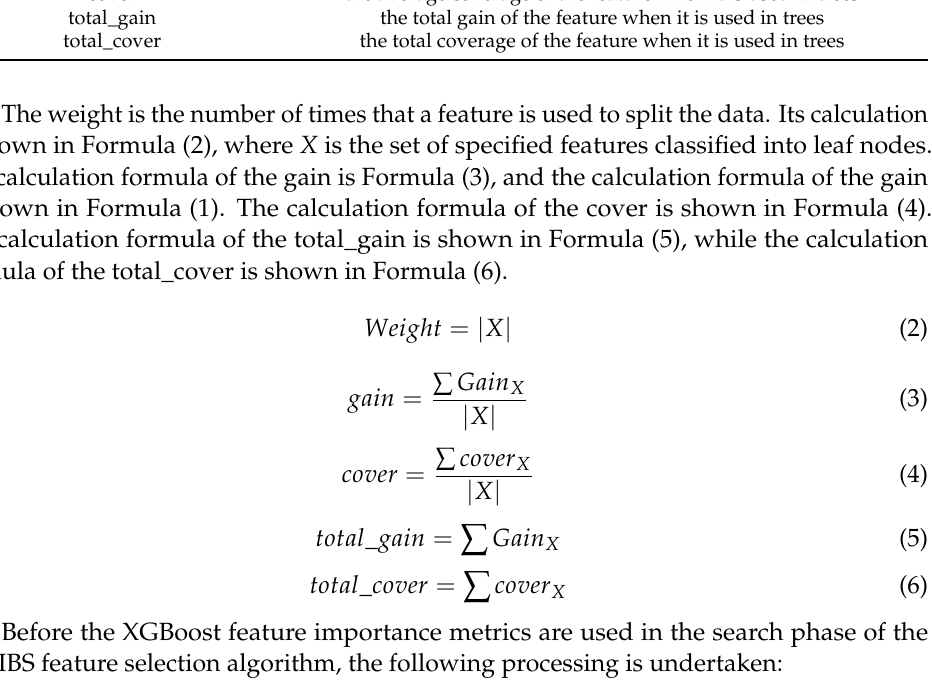
Table 5. Descriptions of the XGBoost feature importance measurement metrics. Parameter Description weight the number of times a feature is used to split the data across all trees gain the average gain of the feature when it is used in trees cover the average coverage of the feature when it is used in trees